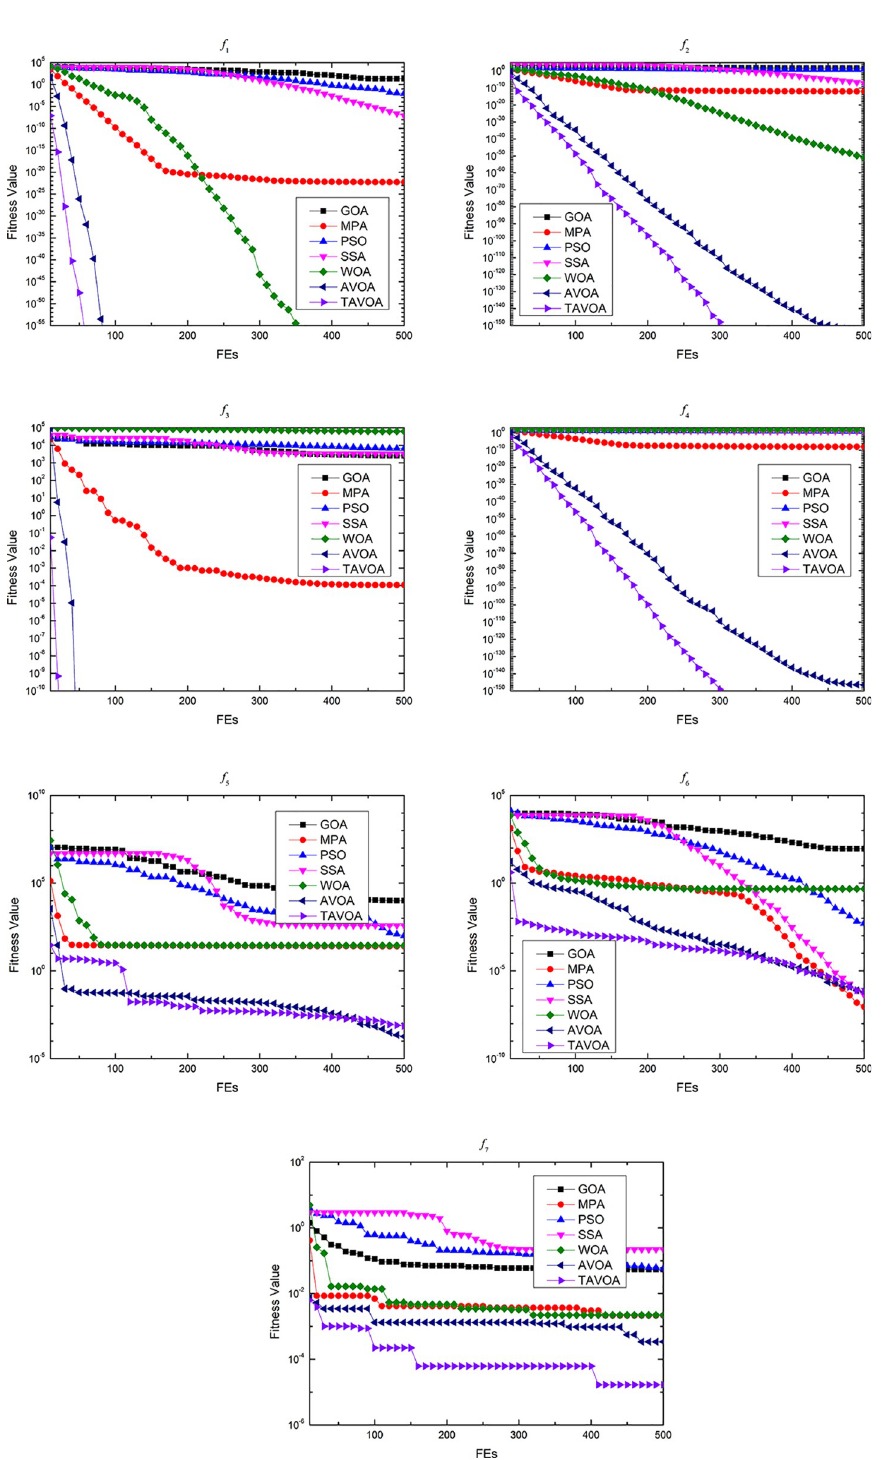
Fig 7. Convergence process on basic unimodal benchmark functions.